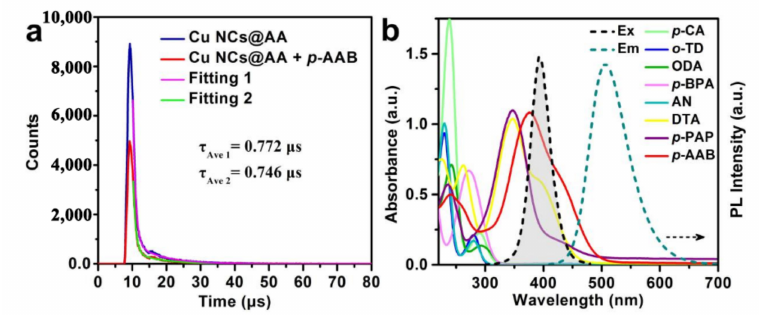
Figure 10. ( a ) The PL decay curves of Cu NCs aqueous solution before and after the addition of p-AAB at room temperature under excitation at 393 nm. ( b ) Spectral overlap between fluorescence spectrum of Cu NCs@AA (short dash lines) and absorption spectrum of di ff erent aniline compounds solution (solid